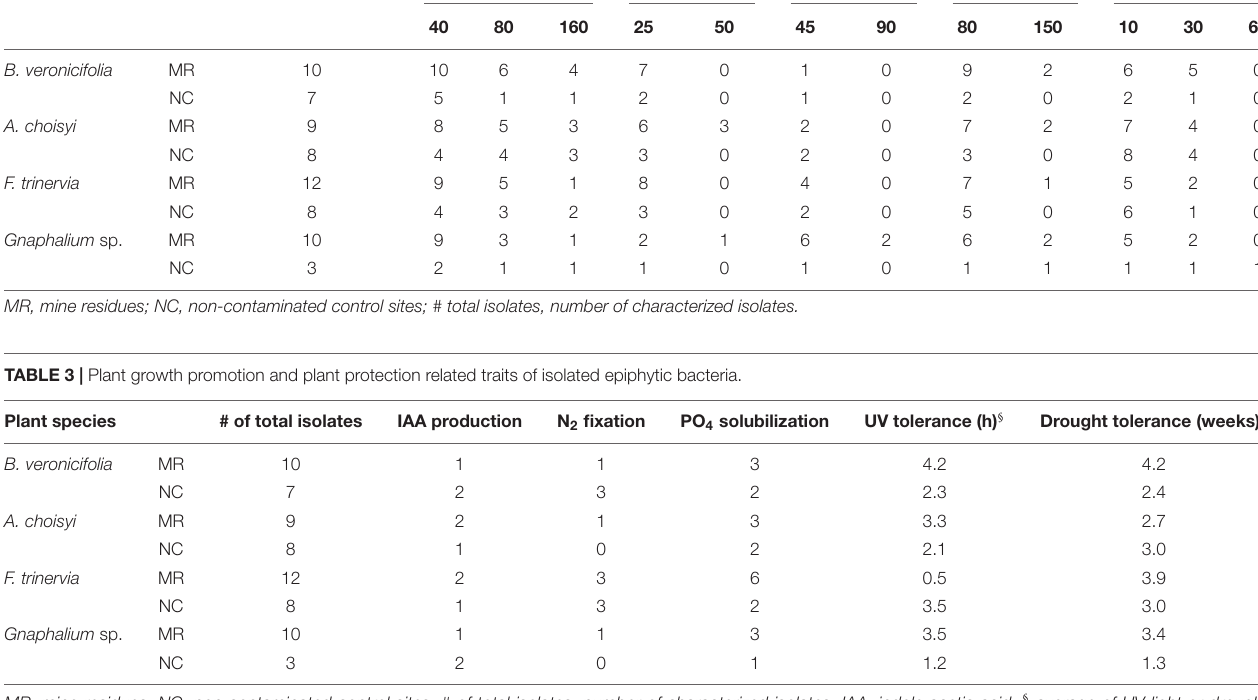
TABLE 2 | Number of epiphytic bacterial isolates tolerant to potentially toxic elements. Plant species # of total isolates